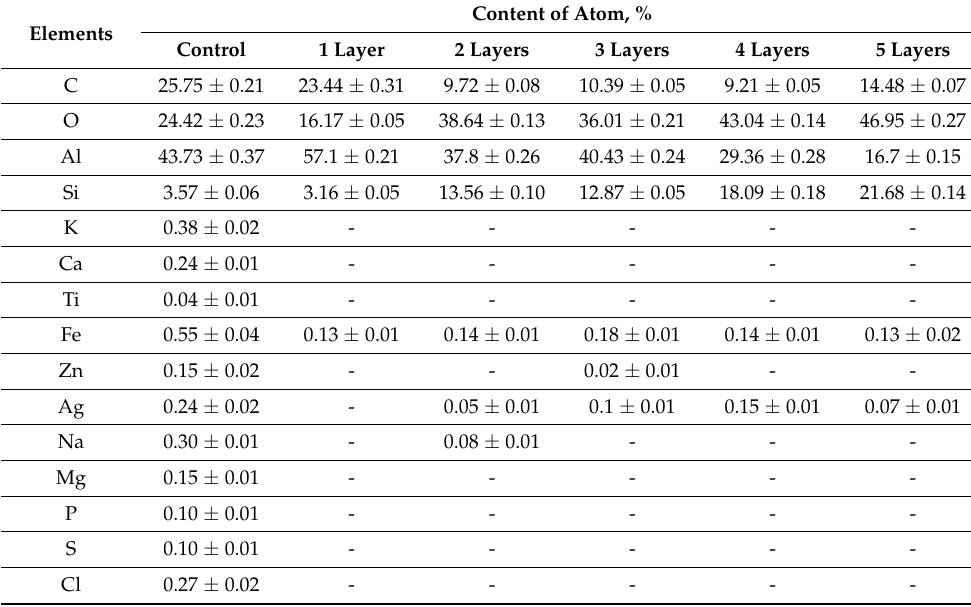
Table 3. The ratio of elements (% atom.) present in the samples prepared with sequential immersion method.